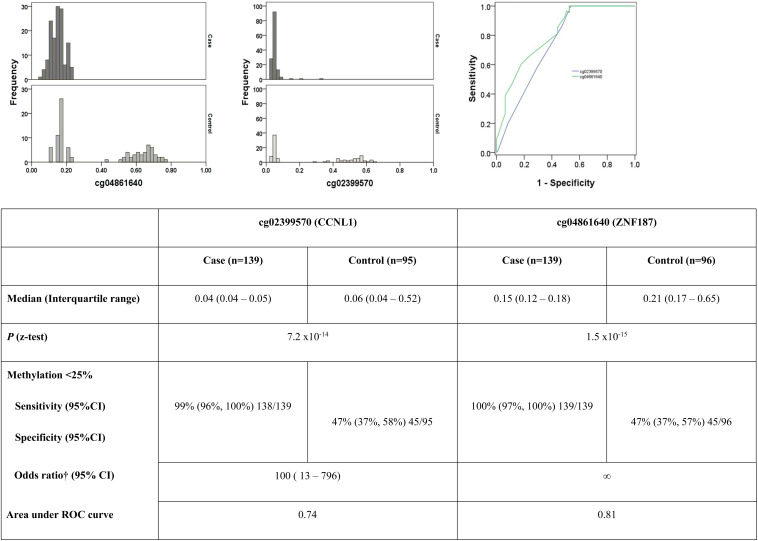
Histograms highlighting differences in the pattern of methylation between cases and controls for the two top ranked markers in the replication population. ROC curve demonstrating sensitivity and specificity of each marker. †Adjusted for age, HbA1c and gender. Neither age at diagnosis, nor duration of diabetes significantly influenced the model.